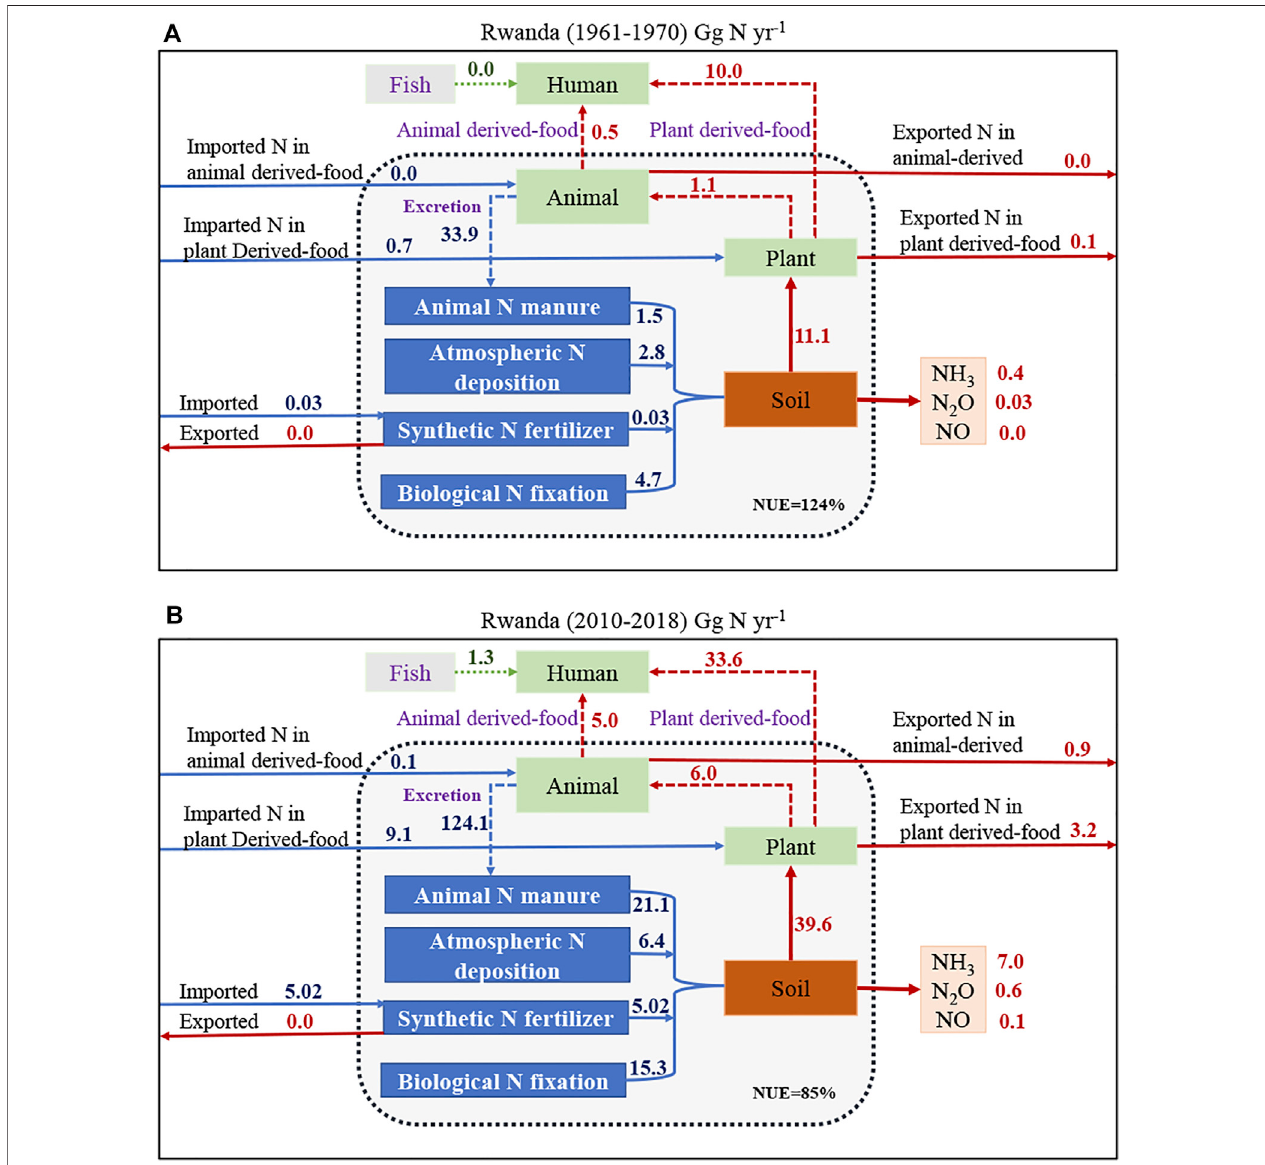
FIGURE 10 | Notable changes in the N fl ux in Rwanda ’ s agro-food system from the 1960s (A) to 2010 – 2018 (B) .